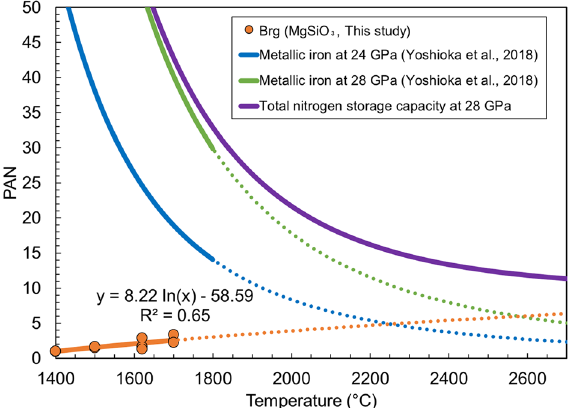
Figure 5. Plots exhibiting the temperature dependence of nitrogen storage in the lower mantle during cooling of the magma ocean. The temperature reaches 2700 °C, which is the melting point of bridgmanite at 28 GPa 40 . The mass of the present atmospheric nitrogen (PAN) is 3.92 × 10 18 kg. In this estimation of nitrogen storage, the total mass of the Earth was assumed as 5.97 × 10 24 kg, of which the lower mantle accounted for 52.2